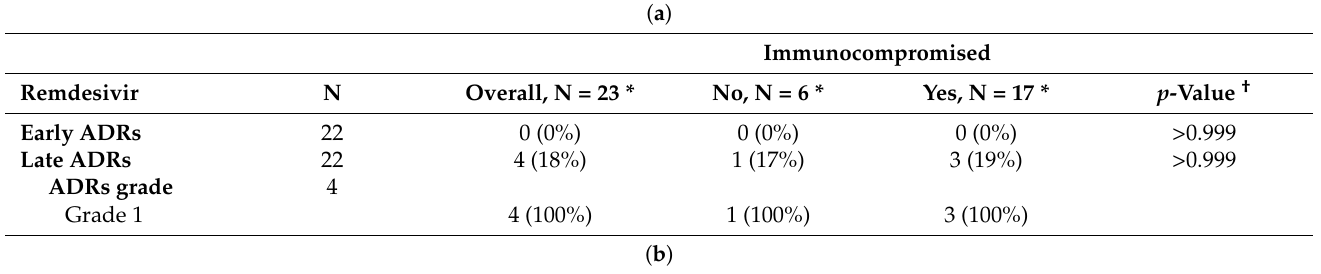
Table 3. Adverse drug reactions according to immune status for those receiving remdesivir ( a ) and monoclonal antibodies ( b ).